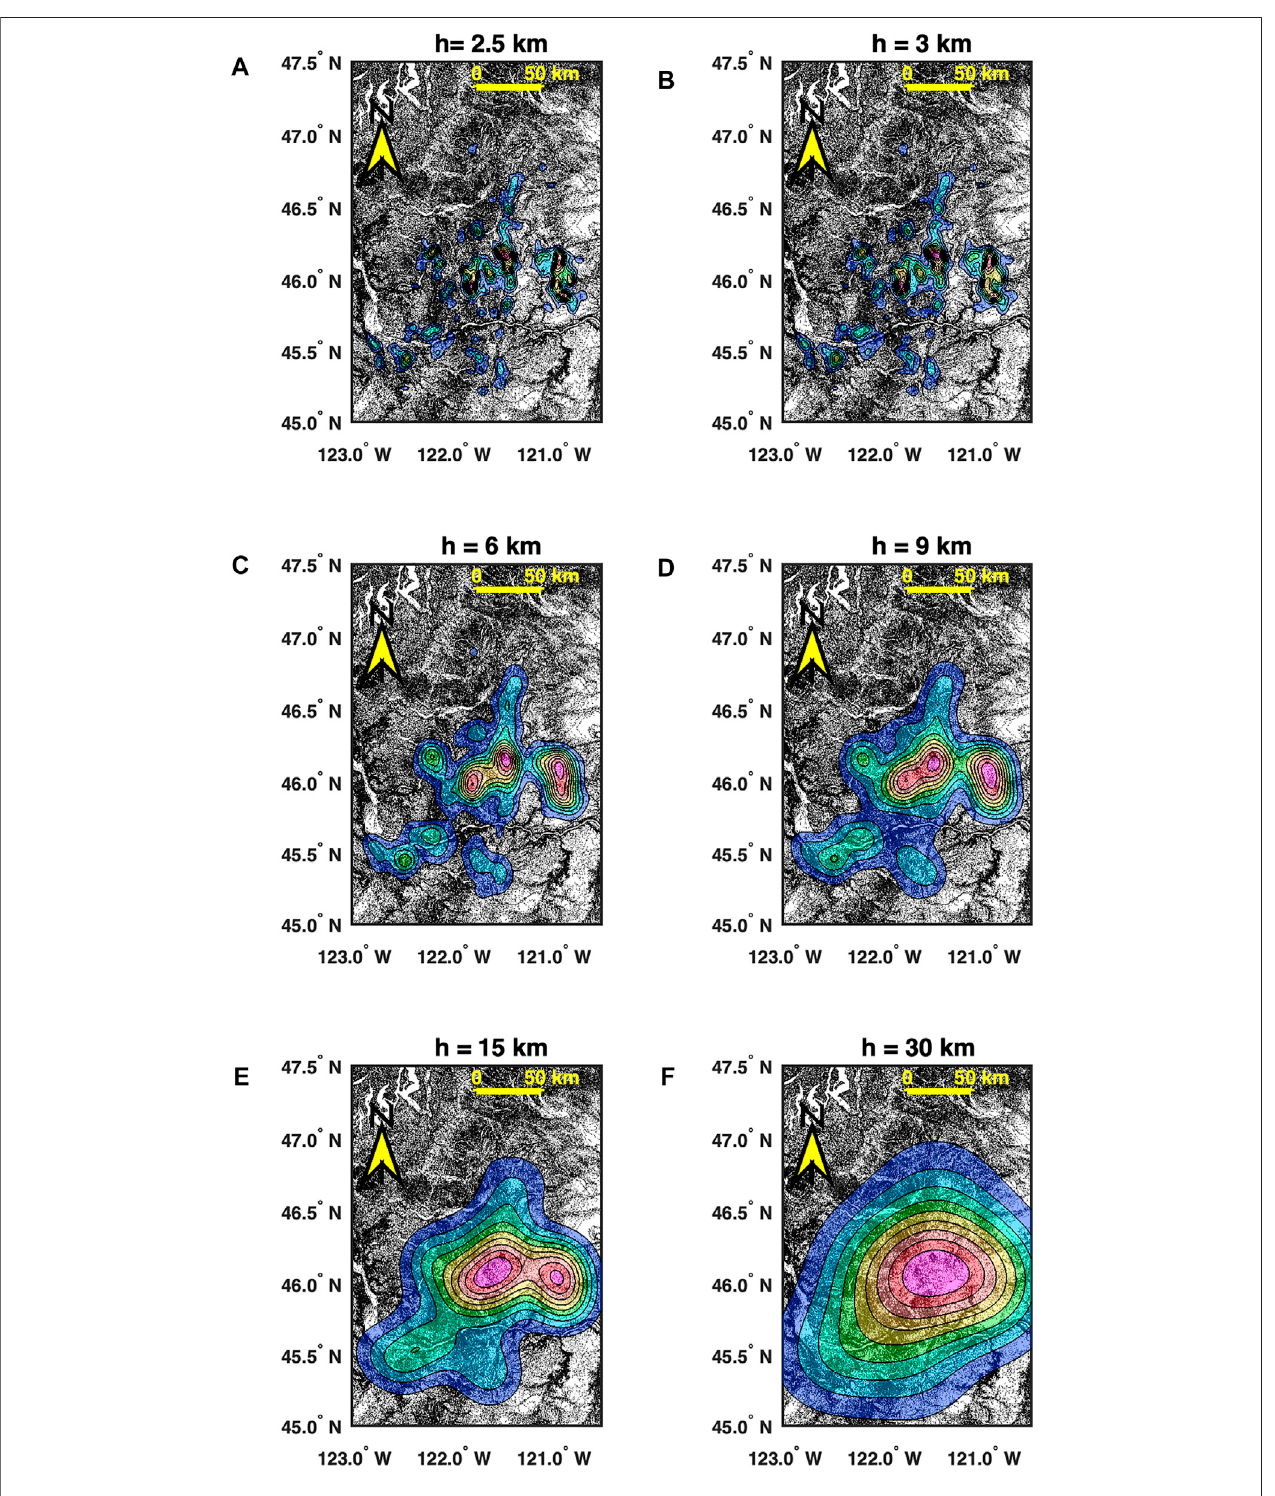
FIGURE 8 | Sequence of PDFs used for exploration of the main features of the PDFs associated with the vent distribution of vents on the Washington Cascades.